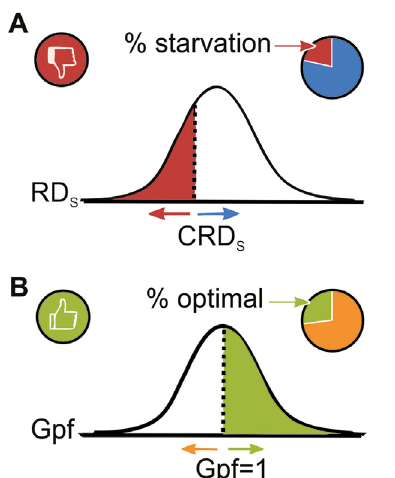
Fig. 2. – Theoretical distribution for (A) RNA/DNA index (RD) and (B) growth Pperformance (Gpf) values for fish larvae. (A) The curve corresponding to RD shows a critical value (CRD) used to detect starving larvae: above this value, the larvae are not in starvation (white colour) and below it they are in starvation (red colour). (B) The Gpf curve represents the growth performance being the quotient between the observed growth rate and the larval growth rate under optimal environmental and feeding conditions. Values greater than 1 (green colour) indicate more than optimal growth, and values less than 1 (white colour) indicate less than optimal growth. Modified from Alves et al. (2022).